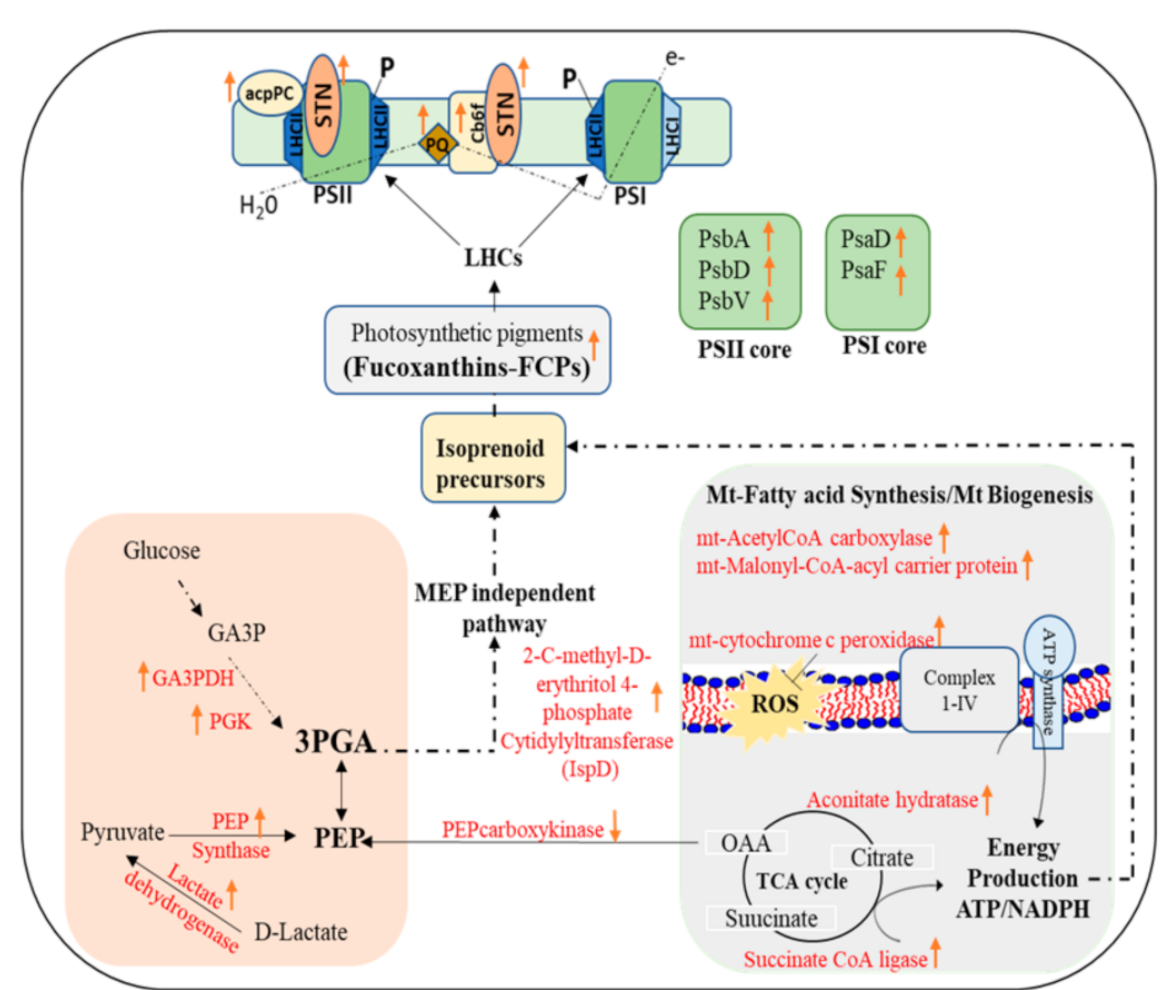
Figure 5. Schematic description of the molecular mechanism of peridinin-chlorophyll - protein complex (PCP) light harvesting protein accumulation under low light in Symbiodinium tridacnidorum . This involves the upregulation of mevalonate-independent pathway and mitochondrial biogenesis for isoprenoid based photosynthetic pigments biosynthesis. STN—Serine/threonine-protein kinase; LHC—light harvesting complex; GA3P—glyceraldehyde phosphate; GA3PDH— glyceraldehyde phosphate dehydrogenase; PGK—phosphoglycerate kinase; PEP-phosphoenol pyruvate; OAA-oxaloacetate; PGA—phosphoglycerate; FCPs—fucoxanthin Chl a/c protein complex; acpPC—chlorophyll a –chlorophyll c2 –peridinin- protein-complex; PS—photosystem;